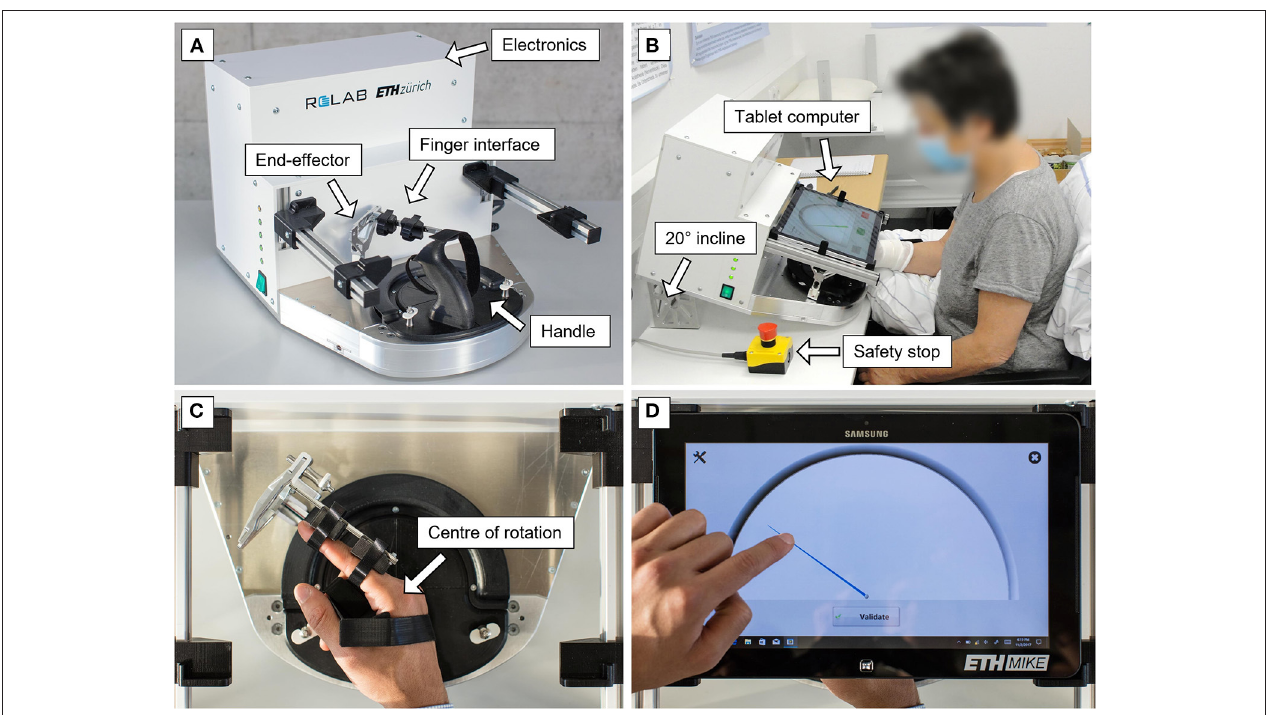
FIGURE 1 | ETH MIKE robotic device for the assessment of finger proprioception. (A) The components of the platform interfacing with the user are an end-effector, a finger attachment mechanism and an exchangeable 3D-printed handle. In the white box, all electronic components are located (including an actuator, which generates end-effector movement through a cable transmission system, for more details see Zbytniewska et al., 2019). (B) To avoid parallax error, the device is inclined at 20 ◦ and participants are seated directly above the tablet computer screen. This image displays an adult participant using the device version based on which the adaptations for children were made. (C) The center of the end-effector rotation occurs around the MCP joint of the index finger. (D) A simple GUI displays the passive position sense assessment. This GUI is a previous version for adults, which will be adapted to suit children’s